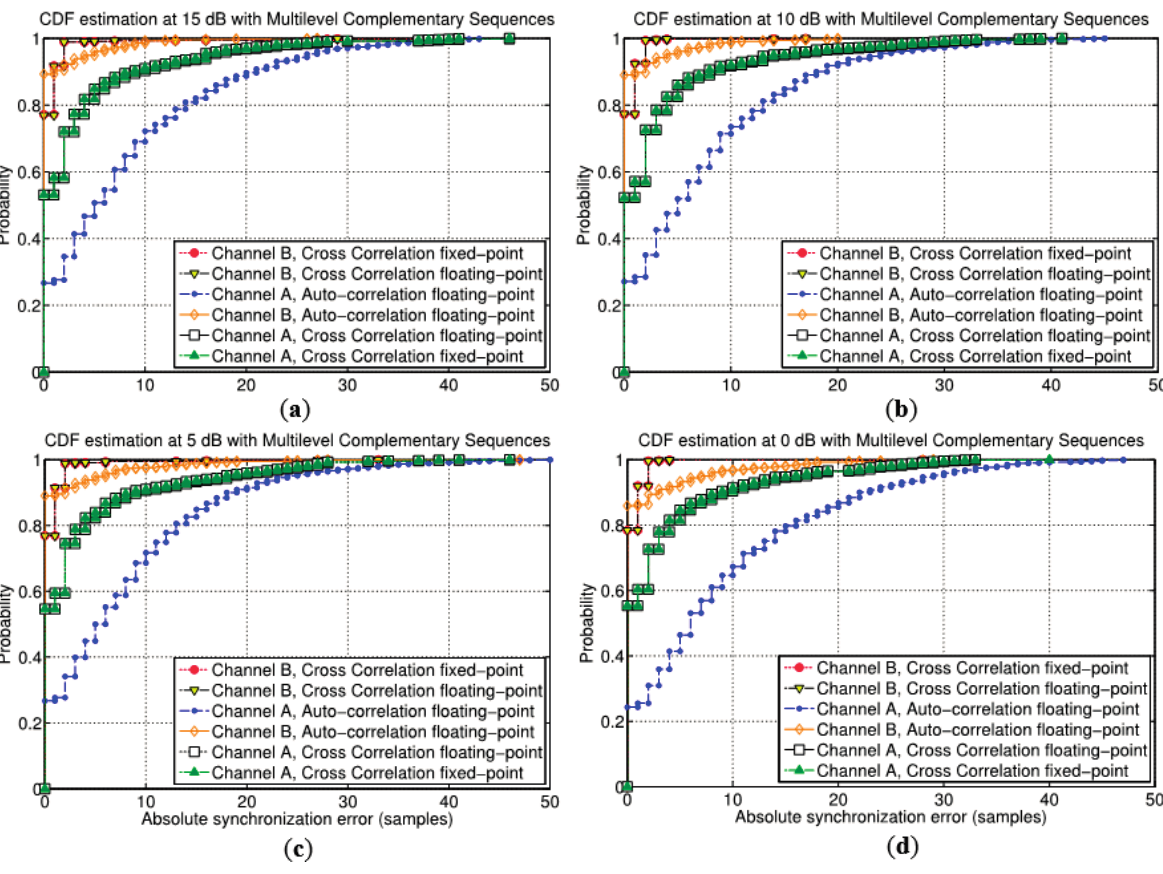
Figure 11. Cumulative distribution function (CDF) of the absolute error in the synchronization delay estimation with different SNR values, ( a ) 15 dB, ( b ) 10 dB, ( c ) 5 dB, ( d ) 0 dB, for both models A and B, for the auto-correlation method and for the floating- and fixed-point versions of the proposed